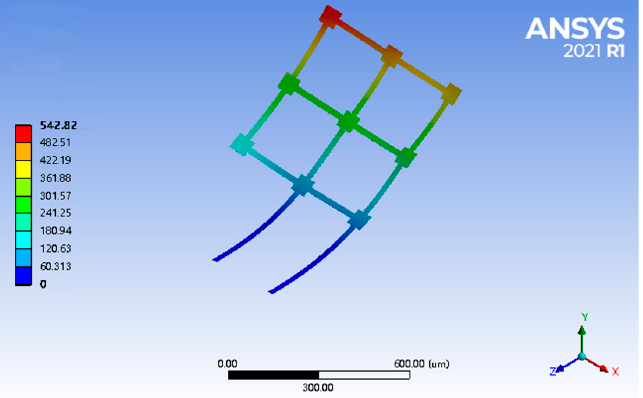
Figure 9. FEA results of the electro-thermo-mechanical deformation when a voltage of 0.04 V was applied between the supporting beams.